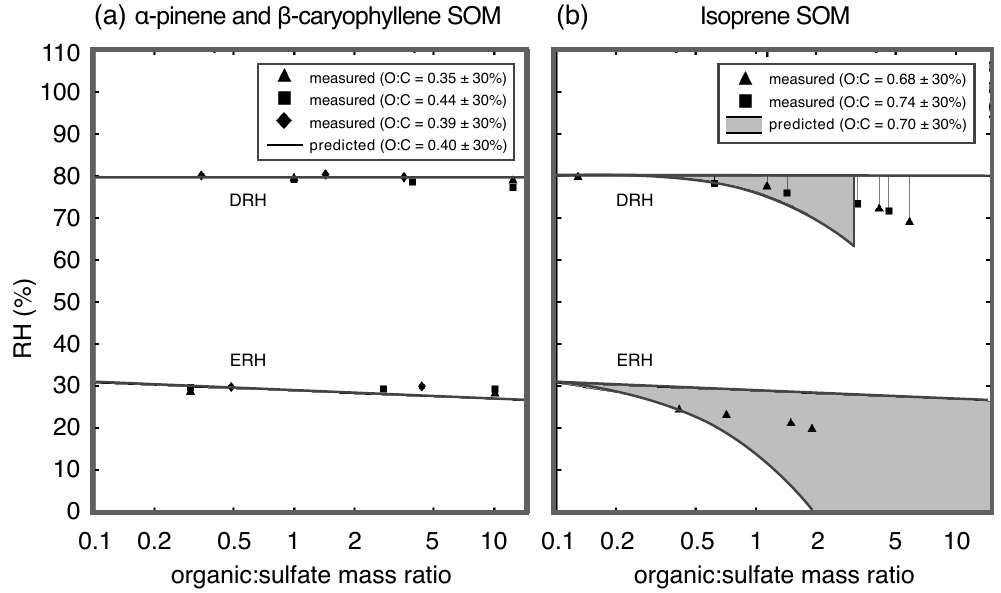
Fig. 6. Comparison between measured and predicted ERH and DRH for organic-sulfate particles. Panel (a) shows observations for organic material produced by the ozonolysis of α -pinene and β -caryophyllene. Panel (b) shows observations for organic material produced by isoprene photooxidation. The predictions shown in each panel represent the ERH and DRH parameterisations with input parameters of the measured org:sulf and O:C, including a maximum 30% uncertainty in the O:C measurements (Aiken et al., 2007). This uncertainty is relatively less important for (a) (thus narrower bands) than (b) (wider bands) because of the different O:C values. The unsymmetrical error bars for the deliquescence measurements in (b) are discussed in the supplementary material. The ERH parameterisations have been adjusted by 4.2% RH to take into account differences in particle size and observation